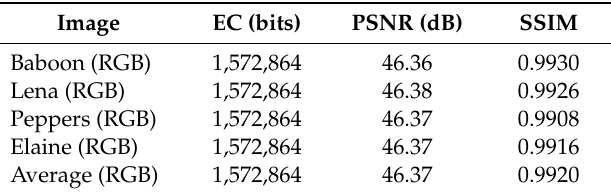
Table 2. Experimental results for color